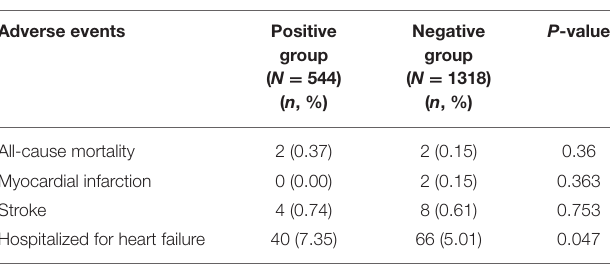
(19, 21) and myosympathetic nerve activity (9, 20, 22). TABLE 3 | Incidence of adverse